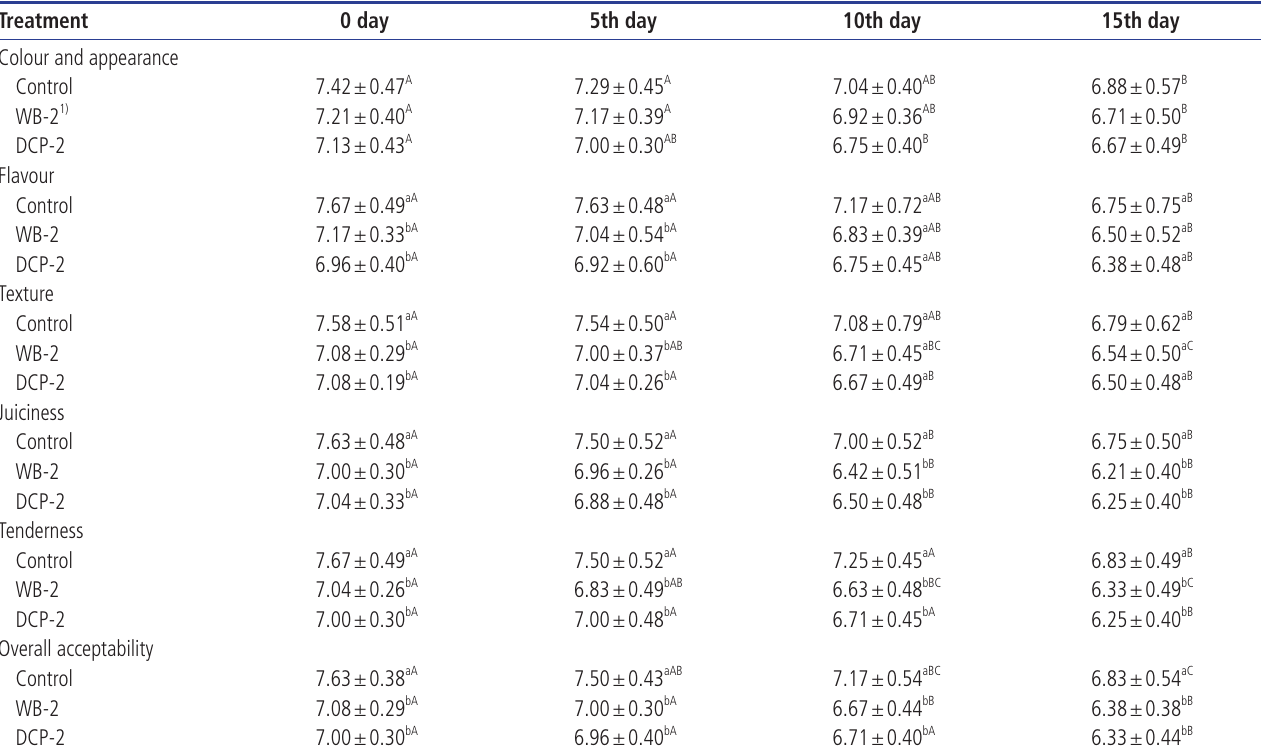
Table 6. Sensory scores of wheat bran and dried carrot pomace incorporated chicken sausages stored at 4°C±1°C